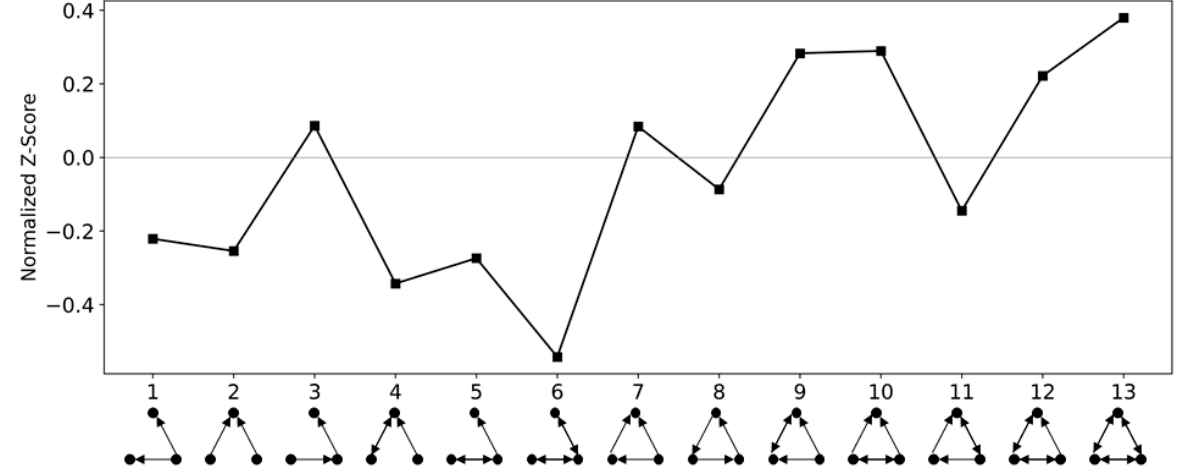
Figure 3. Triad significance profile (TSP) of the global energy trade network. Motifs, which are triads that appear more frequently than expected, include triads 9, 10, 12, and 13. Anti-motifs, which are triads that appear less frequently than expected, include triads 1, 2, 4, 5, and 6. Triad 13 is frequently a motif of human social networks, whereas triad 6 is considered unbalanced and is typically an anti-motif of human social networks. Taken together, this suggests the topology of the global energy trade network is influenced by human sociality.